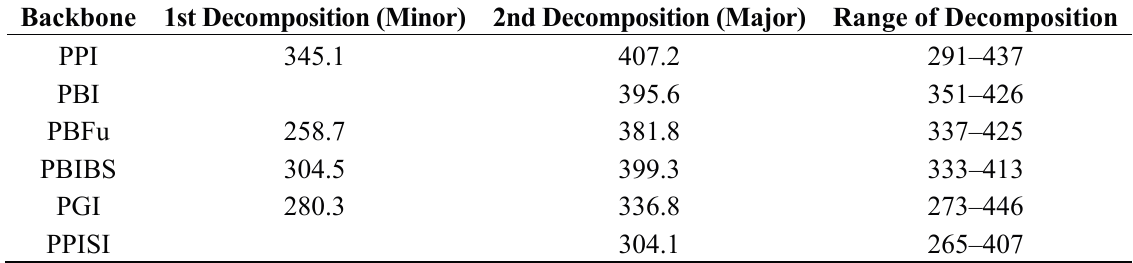
Table 4. TGA temperature of decomposition (°C) and range of decomposition (°C) for the UPE